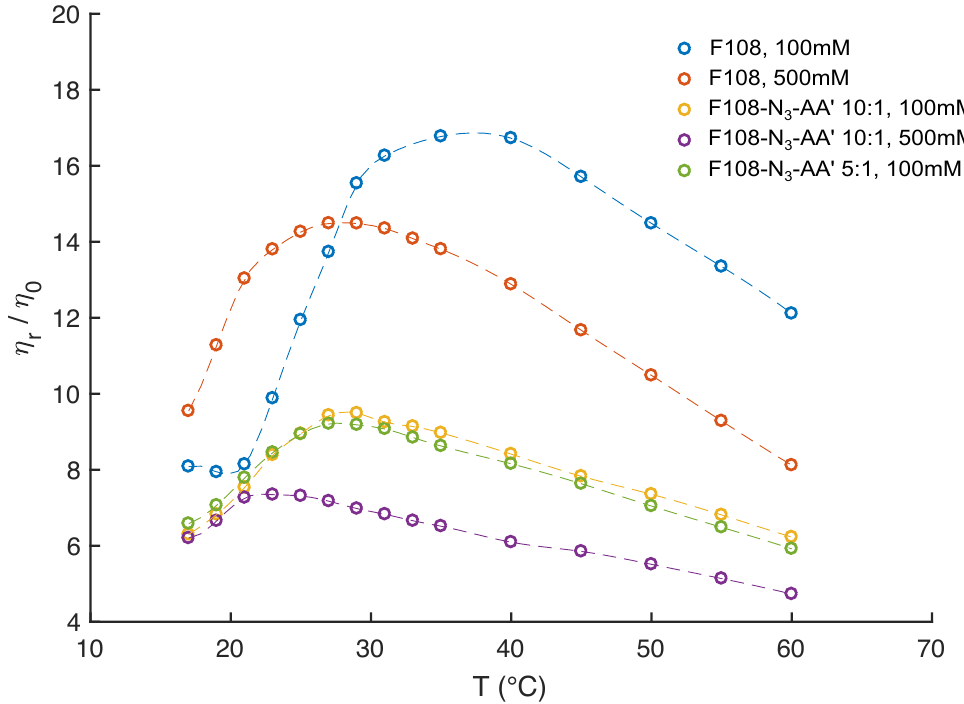
Figure 6. Relative viscosities of 10%w/v F108, F108-N 3 - AA (cid:48) with 10:1 and with 5:1 molar ratios as function of temperature and added NaCl, extracted from MSDs measured in DLS based